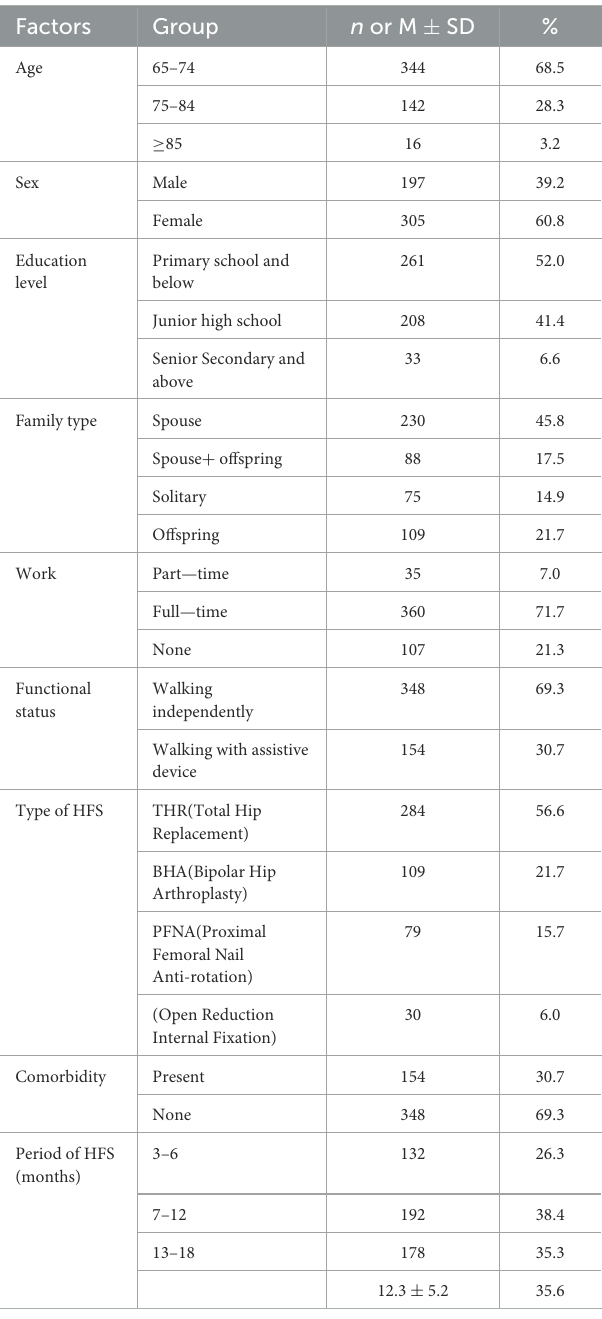
TABLE 1 General demography data ( n = 502). TABLE 2 Item analysis for Chinese version of the self-care scale for older